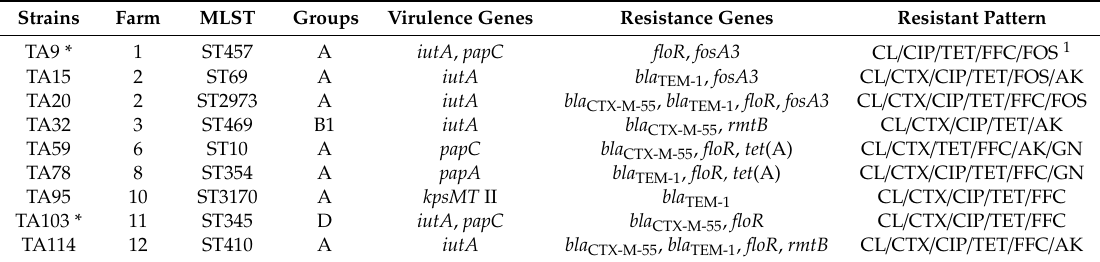
Table 2. Molecular characteristics of the 9 mcr-1 -positive E. coli strains isolated from healthy meat ducks in this study.